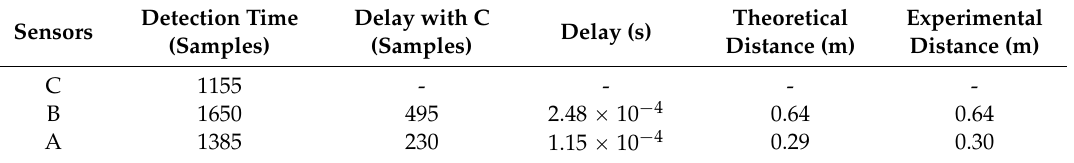
Table 7. Fourth case study: detection time; delay with C; delay; theoretical distance; experimental distance.